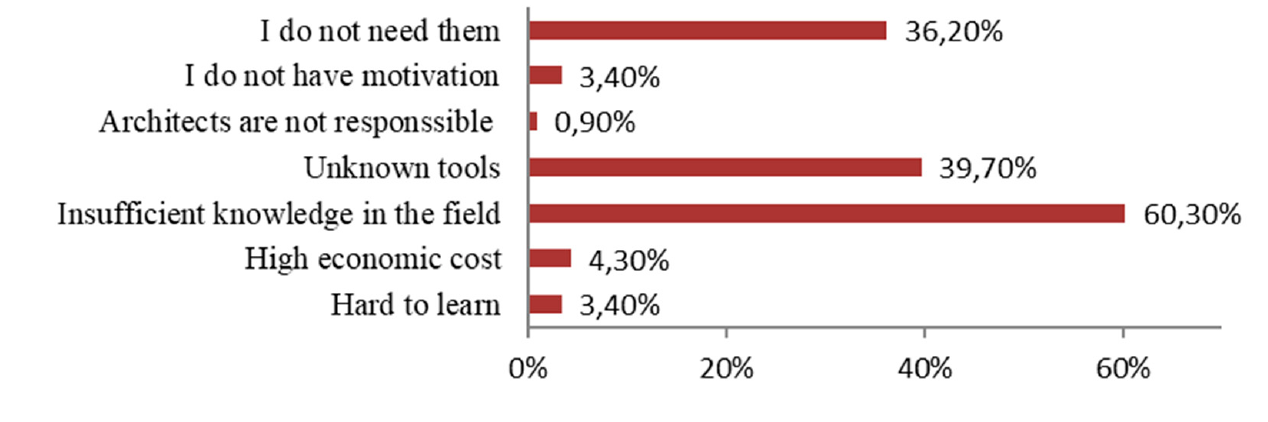
Figure 6. Reasons for not using BPSTs. Table 1. Confidence parameters in the BPSTs. Figure 6. Reasons for not using BPSTs . Table 1. Confidence parameters in the BPSTs . Table 1. Confidence parameters in the BPSTs . Table 1. Confidence parameters in the BPSTs Table 1. Confidence parameters in the BPSTs . Table 1. Confidence parameters in the BPSTs .